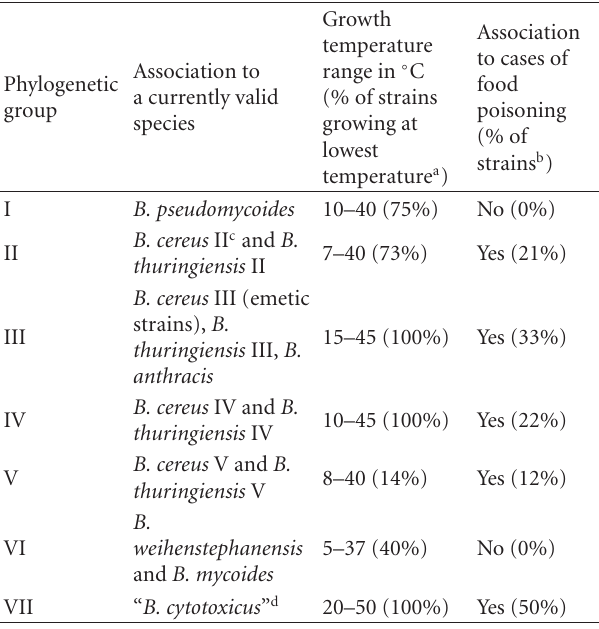
Table 1: Phylogenetic structure of the B. cereus group and characteristics based on data from Guinebreti`ere et al.